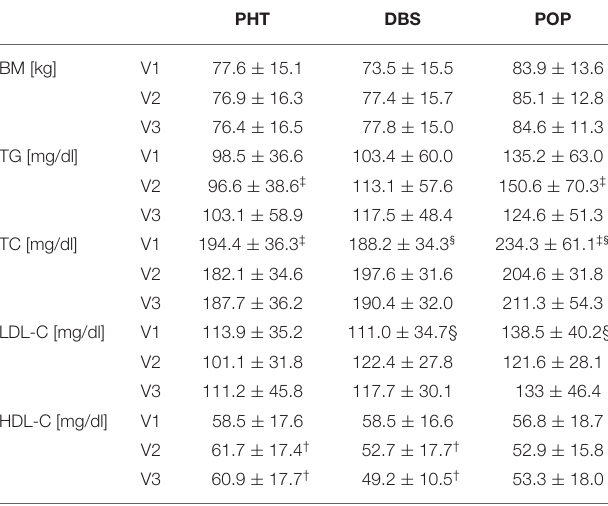
TABLE 2 | Body weight and serum lipids of included patients at consecutive visits (V1. V2.